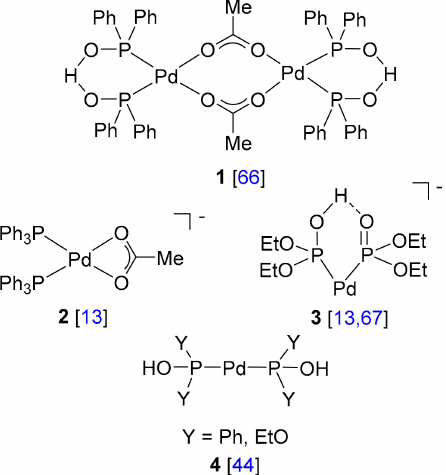
Figure 2. Pd complexes assumed in the Hirao reaction